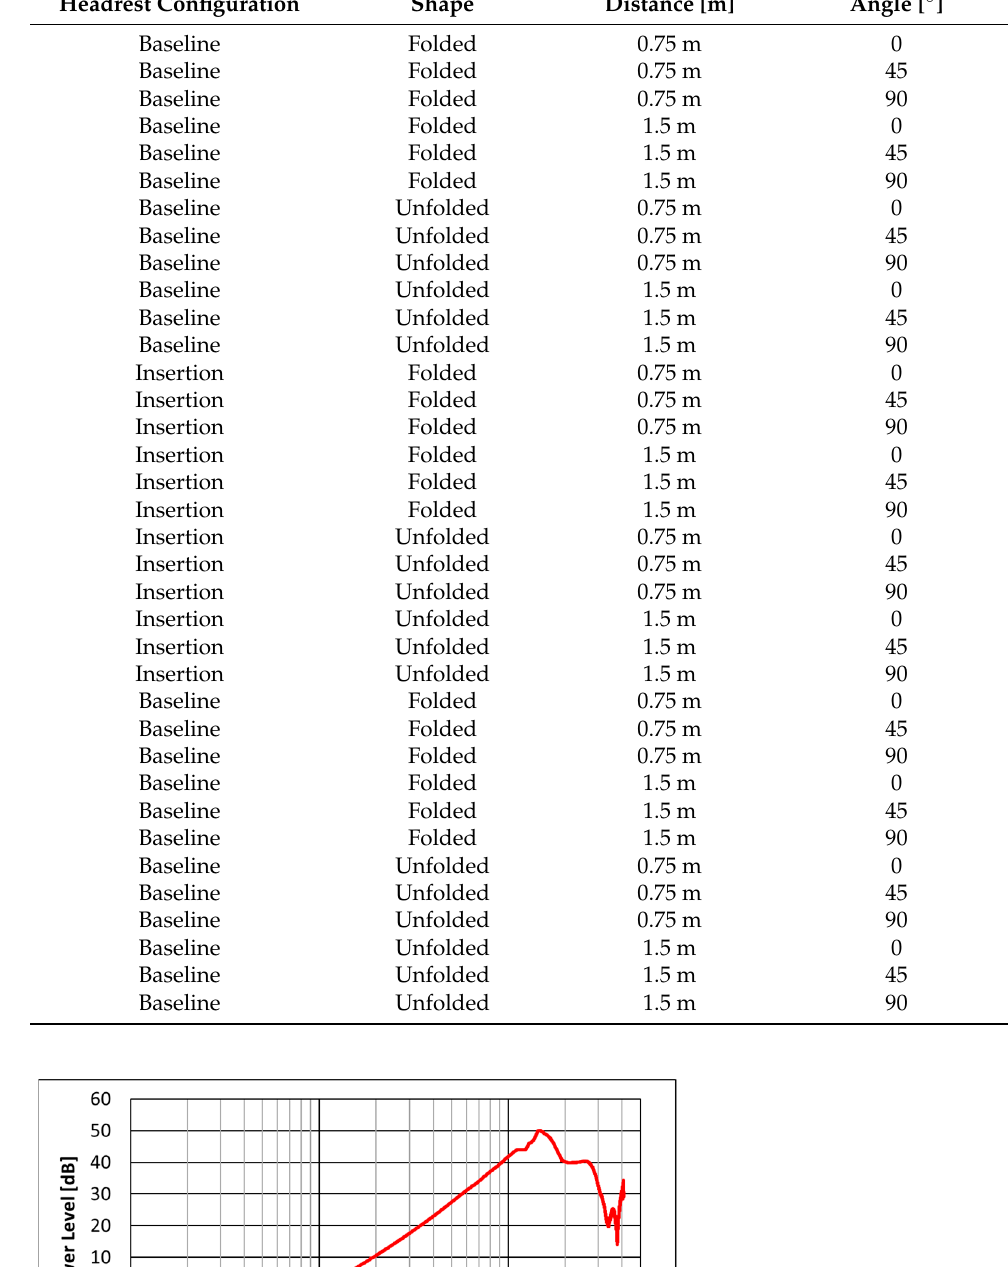
Table 1. Experimental test matrix.